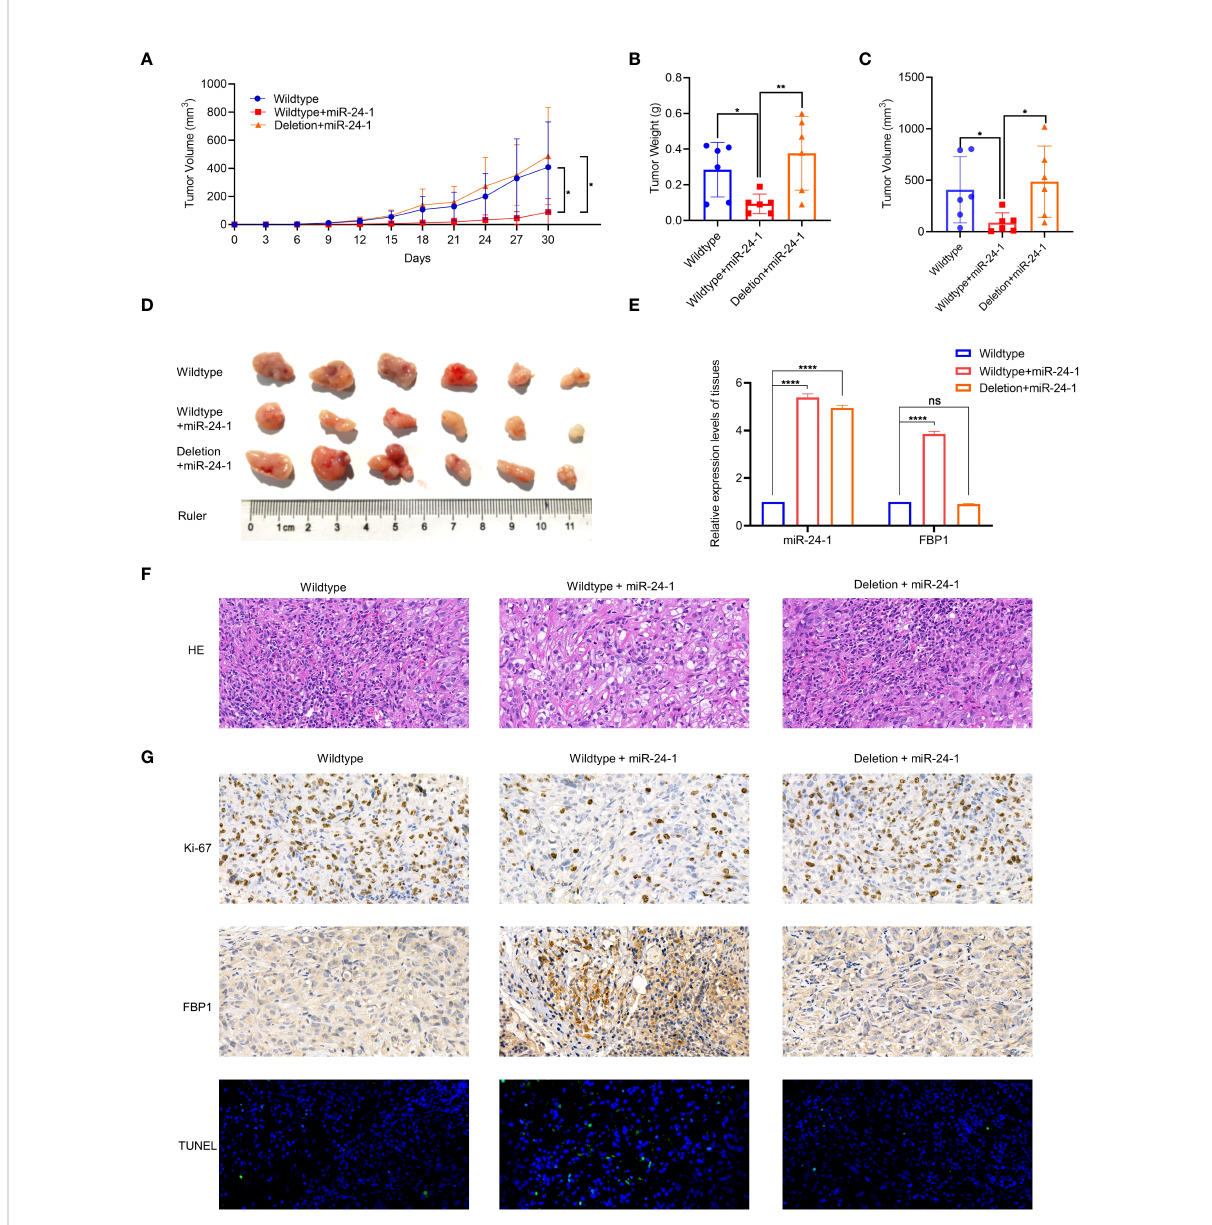
FIGURE 6 MiR-24-1 activates FBP1 via enhancer to suppress tumor growth in vivo . (A) Measuring tumor sizes every 3 days during feeding period. The day when tumors were initially formed marked as day 0. Mice were sacri fi ced on day 30. (B, C) The weight and size of tumors were calculated. (D) The dissected tumors from sacri fi ced mice were photographed. (E) qPCR assay was performed to detect the expression levels of miR-24-1 and FBP1 in the tumor tissues among three groups. (F) Representative images of HE staining of tumors. HE staining con fi rmed that the tumors in each group were indeed RCCs (magni fi cation, 500×). (G) Representative images of immunohistochemistry of tumors. The expression of Ki-67 was obviously less in the tumors from overexpressing miR-24-1 group than those from control group and enhancer-deleted group (top). The expression of FBP1 was increased by overexpressing miR-24-1, but not when enhancer was deleted (middle). The number of TUNEL-positive cells (green fl uorescent signal) in the overexpressing miR-24-1 group was signi fi cantly increased, indicating an increase of the apoptosis of tumor cells in this group (bottom) (magni fi cation, 500×). Results are shown as mean ± S.D., **p < 0.01, *p < 0.05, ****p < 0.0001, ns means not signi fi